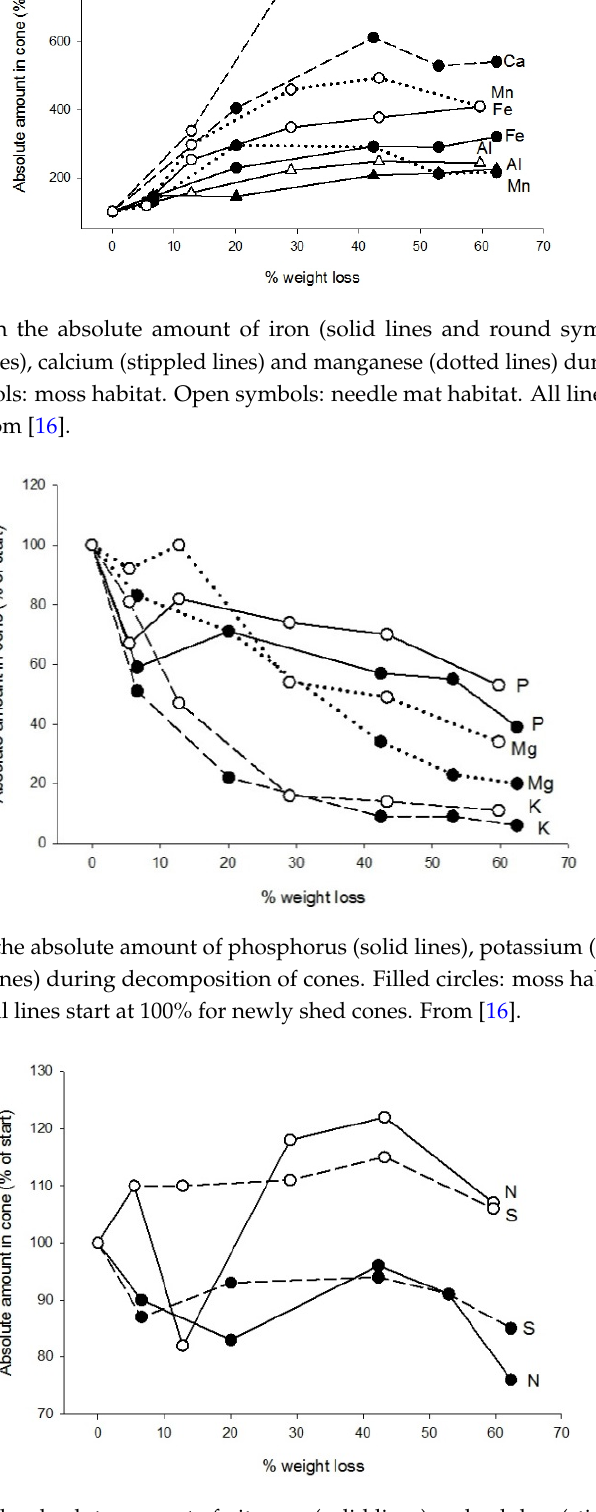
Figure 5. Changes in the absolute amount of nitrogen (solid lines) and sulphur (stippled lines) during decomposition of cones. Filled circles: moss habitat. Open circles: needle mat habitat. All lines start at 100% for newly shed cones. From [16].